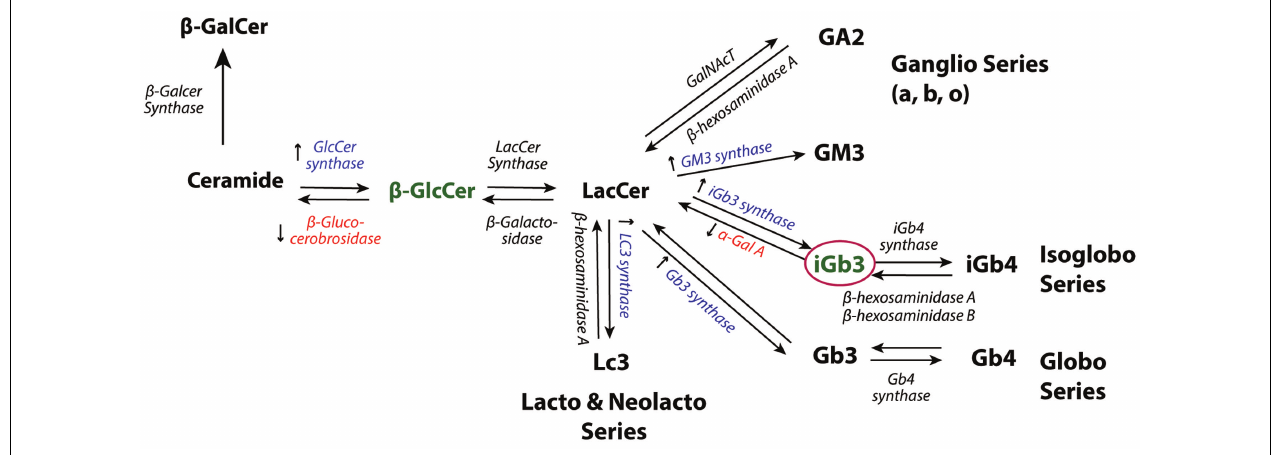
synthase (49), Gb3 synthase (49), and LC3 (49) are reported to be upregulated at the transcriptional level in response to TLR stimulation. Downregulation of β -glucocerobrosidase (48) and decreased activity of α -galactosidase A ( α -Gal A) (76) have also been shown in response to TLR